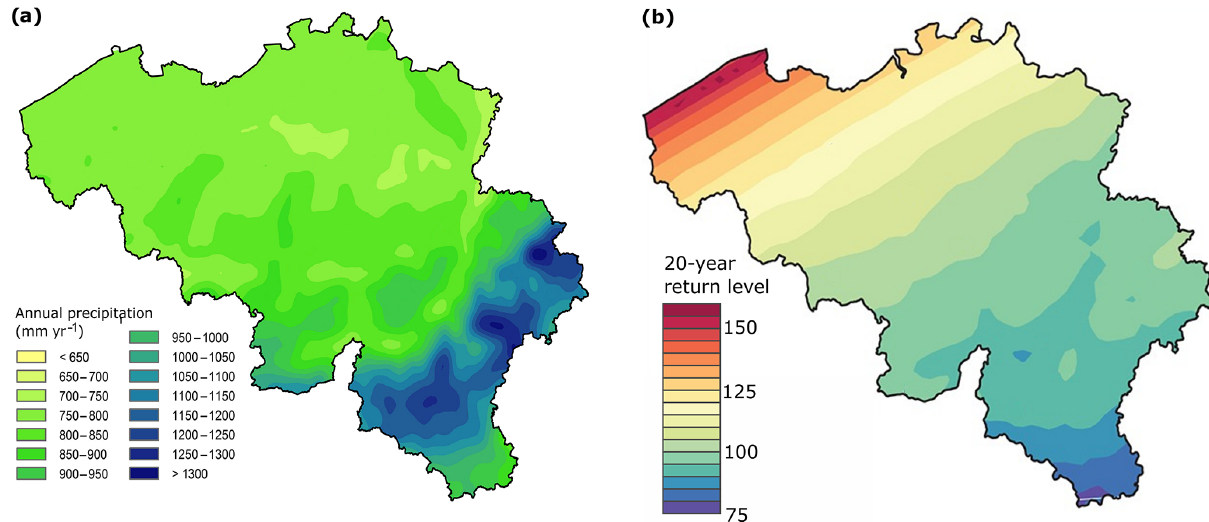
Figure 4. (a) The average annual rainfall in Belgium (Meersmans et al., 2016), and (b) the 20-year return level of a precipitation deficit expressed in days, and calculated in reference to the evapotranspiration rates of coniferous forests (Zamani et al.,